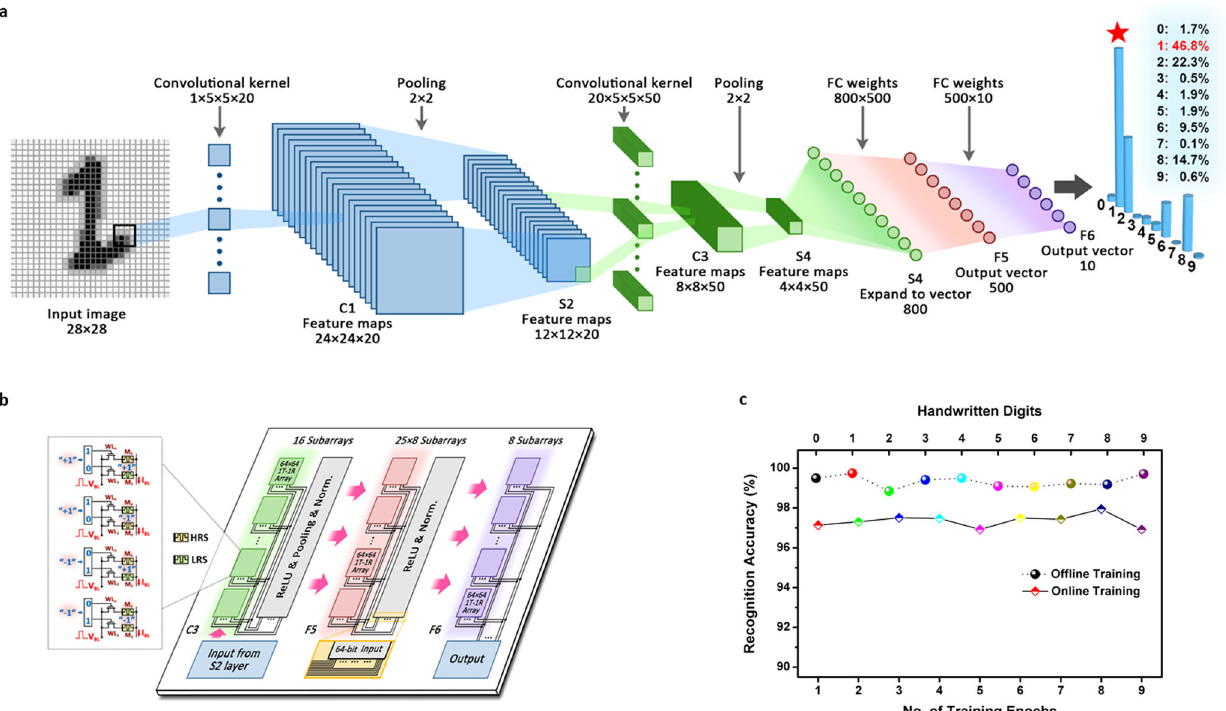
Fig. 6 Simulated neuromorphic pattern recognition based on the 2D polymer memristor devices. a Architecture of LetNet-5 binary neural network for handwritten digits recognition. b Illustration of the PBDTT-BQTPA polymer memristor arrays in the binary neural network. Left panel shows the execution of XNOR operation with two bit-cells, wherein each bit-cell of the 64 × 64 subarrays is composed of one polymer device and one NMOS transistor. c Recognition accuracies of the handwritten numeral images from the MNIST dataset through of fl ine and online